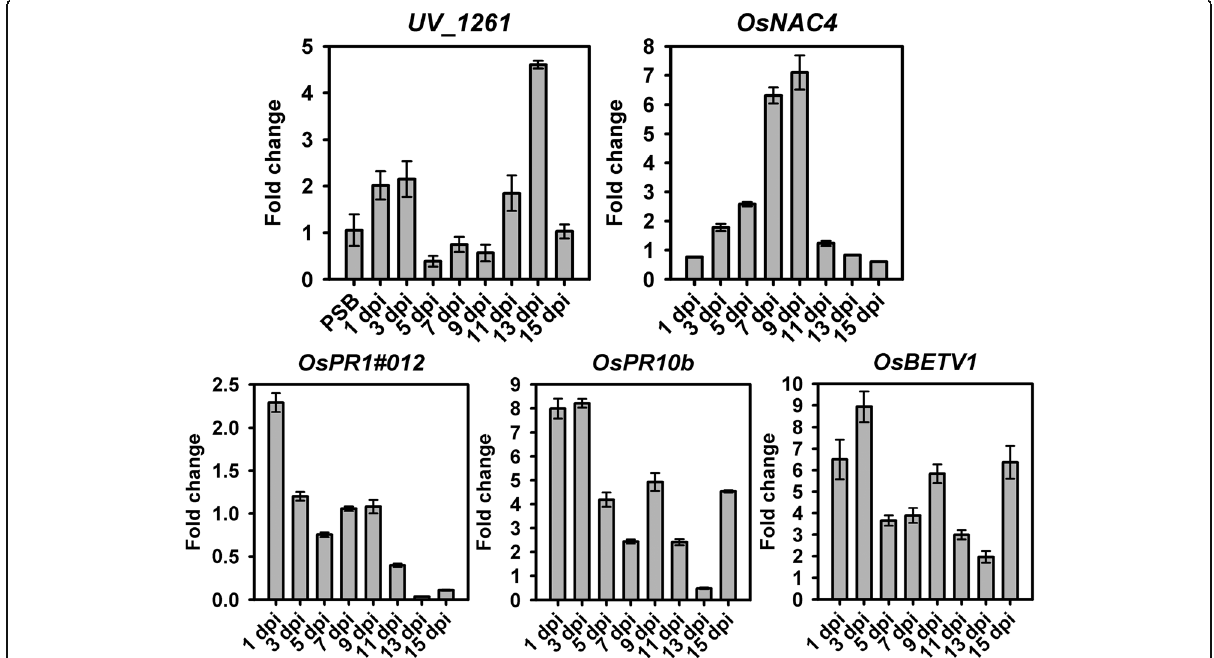
Fig. 1 Expression patterns of UV_1261 and rice defense-related genes. Total RNAs were prepared from samples collected from 7-day-old PSB-cultured PJ52, and PJ52- or mock-inoculated rice spikelets at indicated time points. RT-qPCR was performed for expression profiling of UV_1261 , OsNAC4 , OsPR1#012 , OsPR10b and OsBETV1 . UvTub2 α or OsUbi was used as the reference gene for U. virens or rice gene quantification, respectively. Fold change was calculated by the comparative C T method 2 – ΔΔ CT using PSB-cultured PJ52 as the control for UV_1261 , and using mock-inoculated sample at each time point as the control for rice defense-related genes. Error bars indicate standard deviations ( n